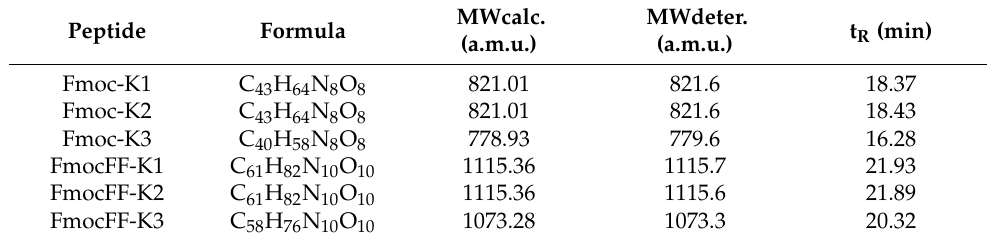
Table 1. Formula, theoretical and experimentally found molecular weight (MW) and retention time of investigated